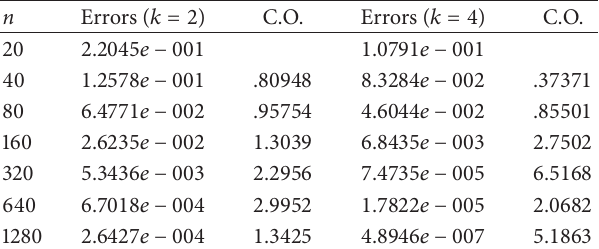
Table 2: Errors of 𝜇(𝑦)